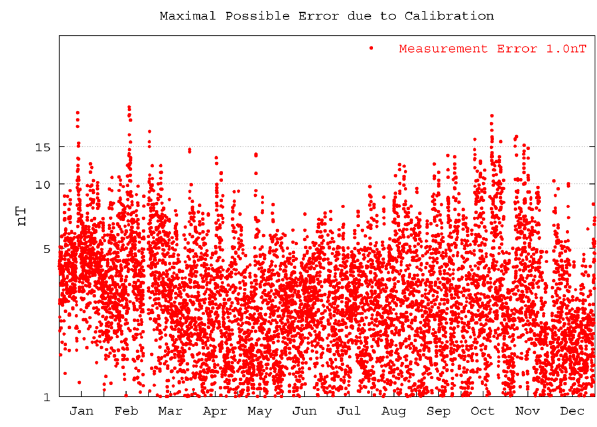
Fig. 4. Normalized histograms of the calibration errors for CLF observatory during 1999: the maximal possible error for εb =0.75, 1, 2nT.